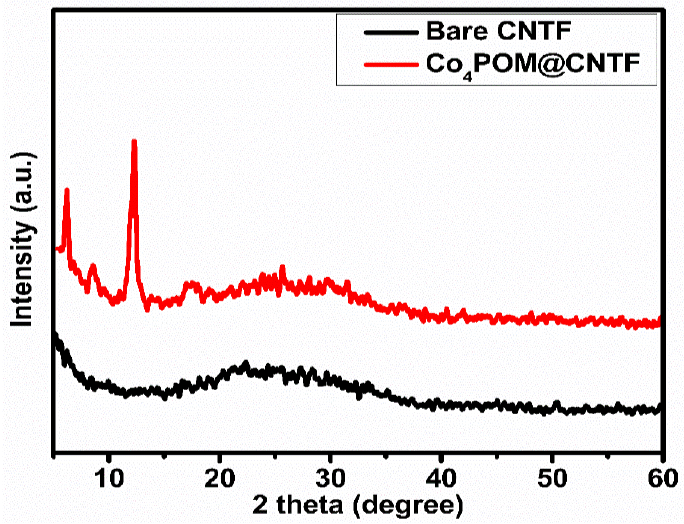
Figure 3. Overlaid XRD spectra of Co 4 POM@CNTF and bare